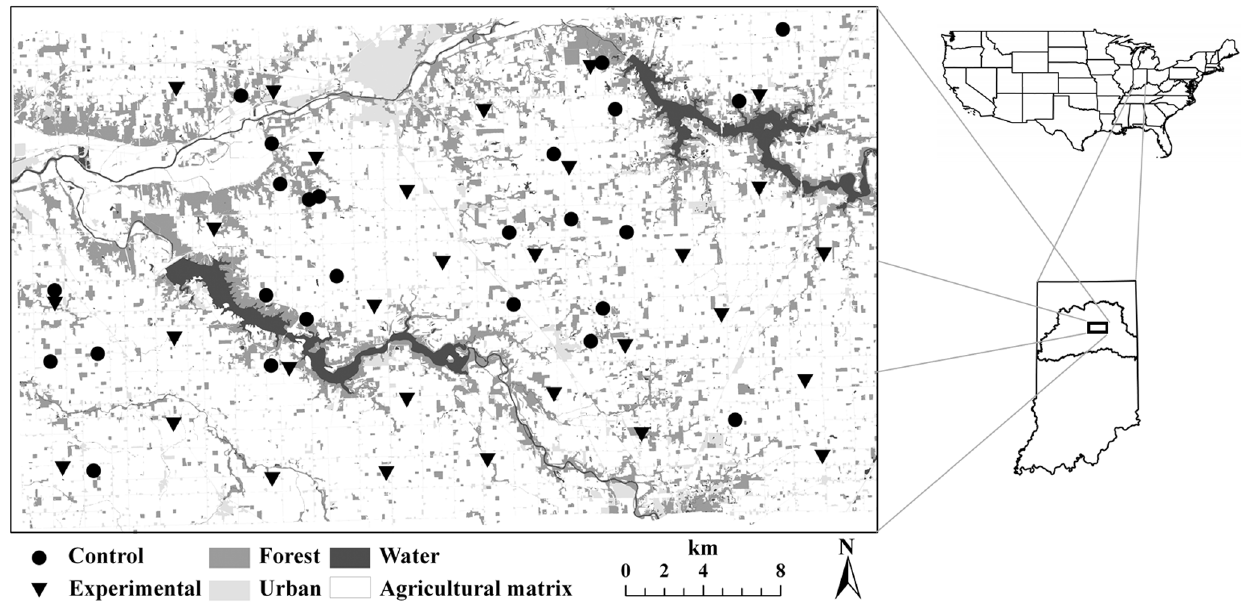
Figure 1. Spatial distribution of experimental ( n =30) and control ( n =25) forest patches used in this study throughout north-central Indiana, USA.